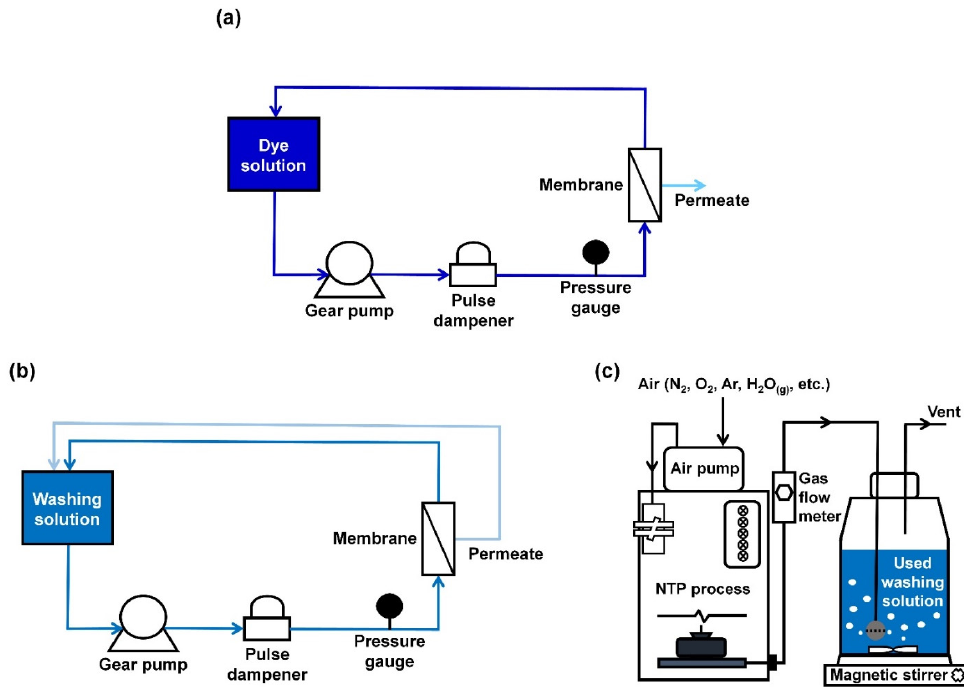
Figure 2. ( a ) Schematic illustration of the crossflow UF system to evaluate the pure water flux and dye removal performances of the as-prepared membrane. ( b ) Schematic illustration of the crossflow system configuration used to wash the used membrane. ( c ) Schematic illustration of a lab-scale set-up of CP treatment system. After membrane filtration for dye removal, a dye solution was drained from the crossflow system, and then the used membrane was washed with a 50% aqueous alcohol (Samchun, Korea) solution at the same operating pressure and crossflow rate for 20 min. While a retentate solution was circulated in the crossflow system, a permeate solution was also returned to the washing solution tank during the cleaning process, as described in Figure 2b, upon consideration that a permeate solution is also supposed to contain a cer- tain amount of dye since the dye removal rate is not 100%. After the washing process, the used washing solution was drained from the crossflow system and collected with de- sorbed dyes from a membrane for reuse, followed by a 10 min rinsing of the system with DI water three times. A series of filtration steps described above was repeated three times. In the meantime, the installed membrane was used repeatedly without disassembling a membrane module (i.e., clean-in-place) in order to determine whether CP treatment effec- tively degrades desorbed dyes in a washing solution and thereby improves the reusability of the used membrane and washing solution. The CP treatment of a used washing solution was carried out with a customized lab- scale CP system (Groon Co., Ltd., Jeonju, Korea) between the previous clean-in-place step and following membrane filtration step for the purpose of removing desorbed dyes in the used washing solution prior to the reuse of the washing solution. The lab-scale CP system featured a threshold current of 10 mA and maximum output power of 2.2 W and consisted of an air pump (Shinhwahightech, ZP-25, Chungju, Korea), a CP unit equipped with an electrical circuit and an AC-DC converter (~10 kV), a gas flow meter, and a glass reactor (Figure 2c) [38]. While the ambient air passed through the CP unit at 5 L min − 1 , the sup- plied air was converted into reactive oxygen/nitrogen species and their derivatives and